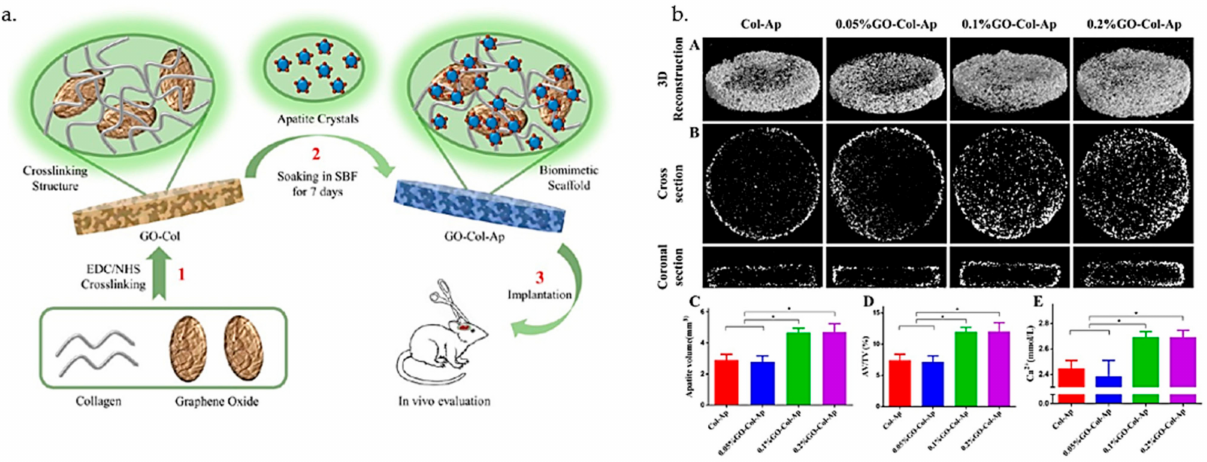
Figure 2. ( a ) Fabrication scheme of GO-Col-Ap scaffolds obtained through chemical crosslinking; ( b ) quantitative analysis and micro-CT images of the scaffolds containing various amounts of GO (* p < 0.05). Reprinted with permission from [118]. Copyright 2018, American Chemical